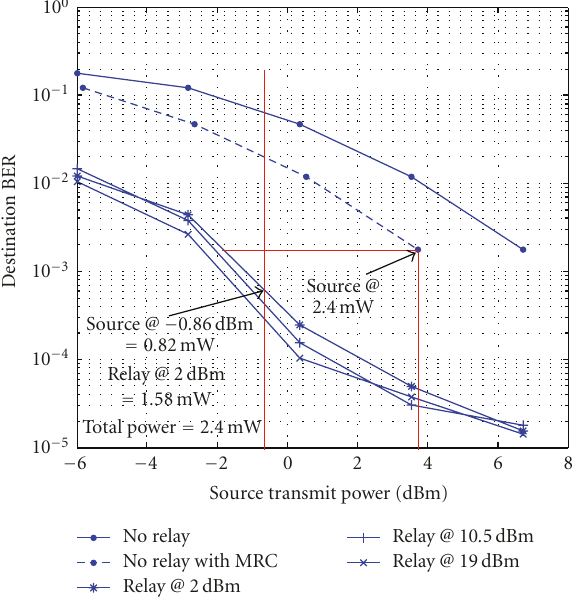
Figure 9: BER results with equivalent power comparison.